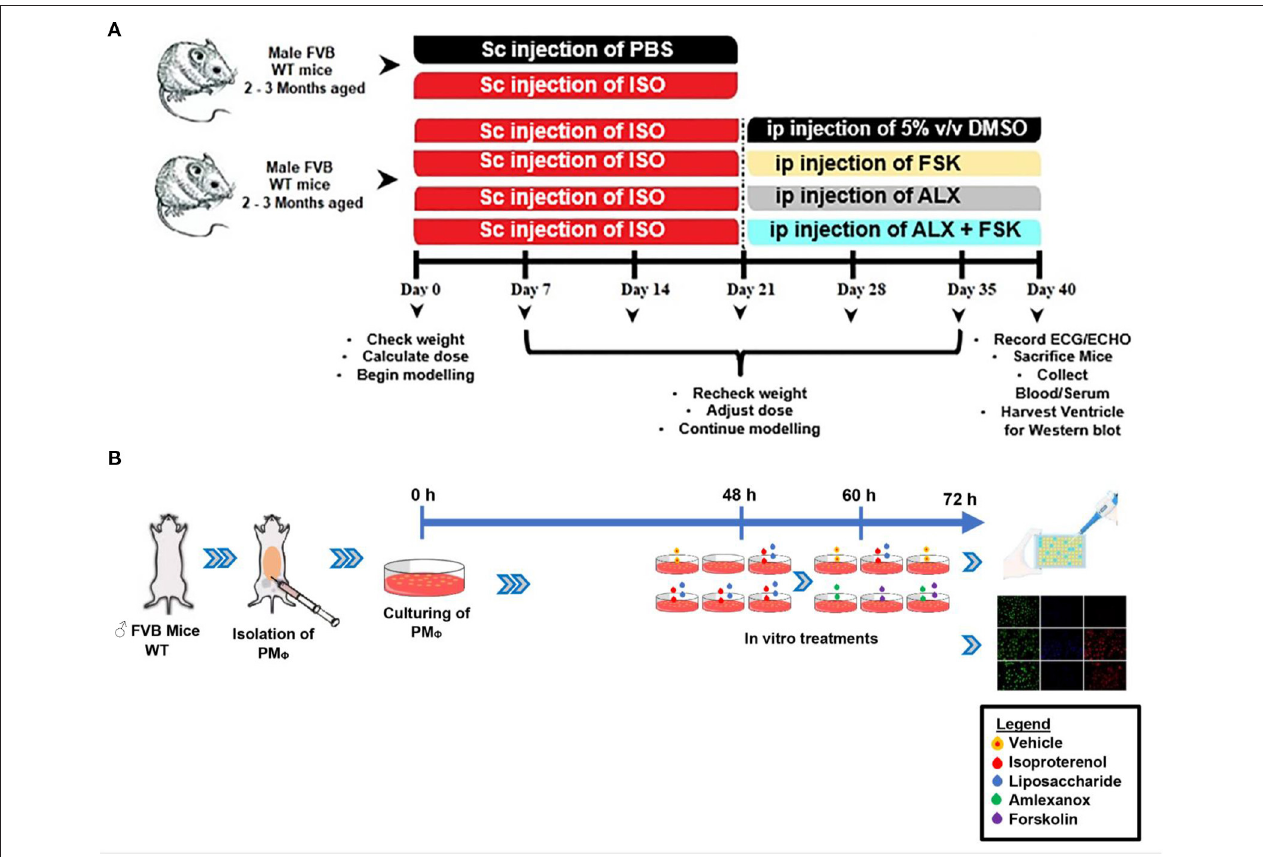
FIGURE 1 | (A,B) Schematic of the experiment design timeline for making in vivo and in vitro models, respectively. ISO, Isoproterenol; Sc, Subcutenous; ip, intraperitoneal; FSK, forskolin; ALX, Amlexanox.